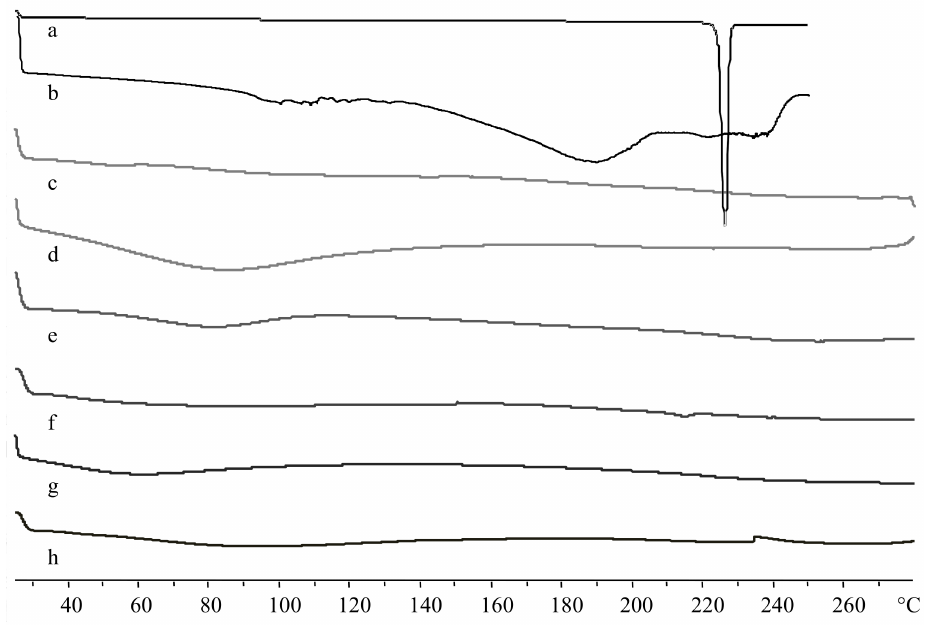
Figure 6. Differential Scanning Calorimetry (DSC) thermograms of TSPO ligands, carboxylated dextran derivatives and TSPO ligand conjugates: 1 (a), 4 (b), 6 (c), 9 (d), 7 (e), 8 (f), 10 (g), and 11